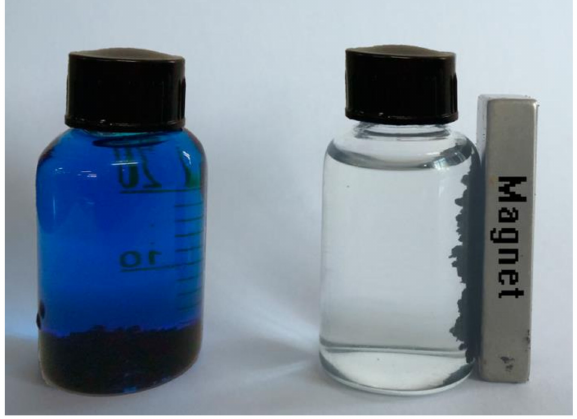
Figure 11. Example of adsorption of methylene blue (MB) followed by removal of the magnetic activated carbon with a magnet (adapted from